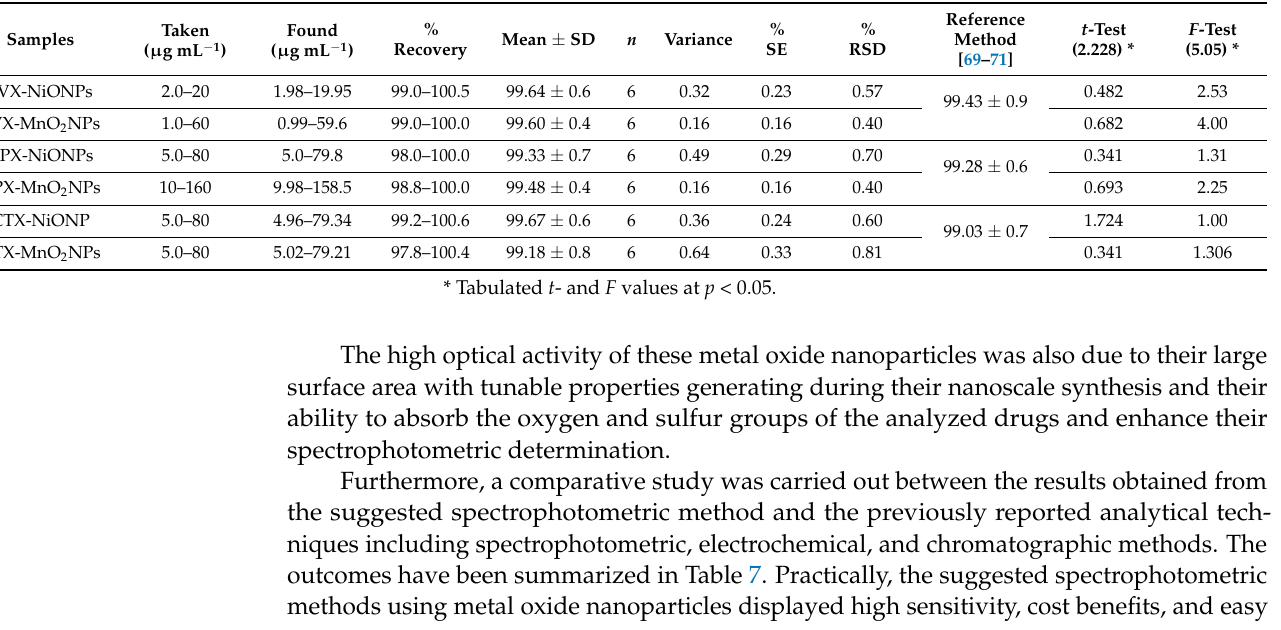
Table 6. Determination of LVX, CPX, and CTX in their commercial dosage forms using spectrophotometry in the presence of NiONPs and MnO 2 NPs,